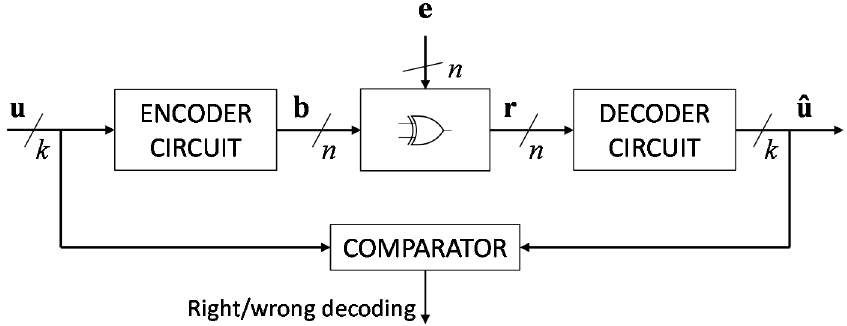
Figure 5. Block diagram of the error injector [21].